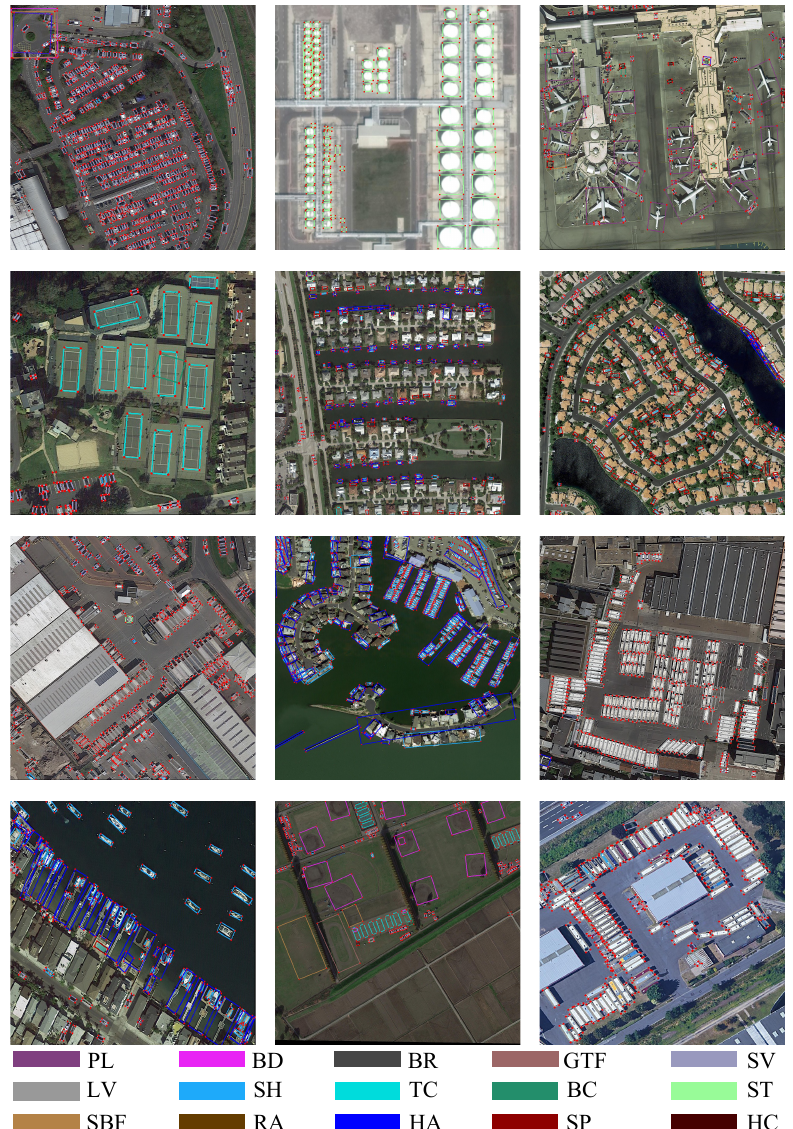
Figure 9. Visualization of the detection results of Point RCNN for the DOTA-v1.0 test set. The score threshold was set to 0.01. Each color represents a category. The red points and colored OBBs are the predicted corner points and the converted OBBs of